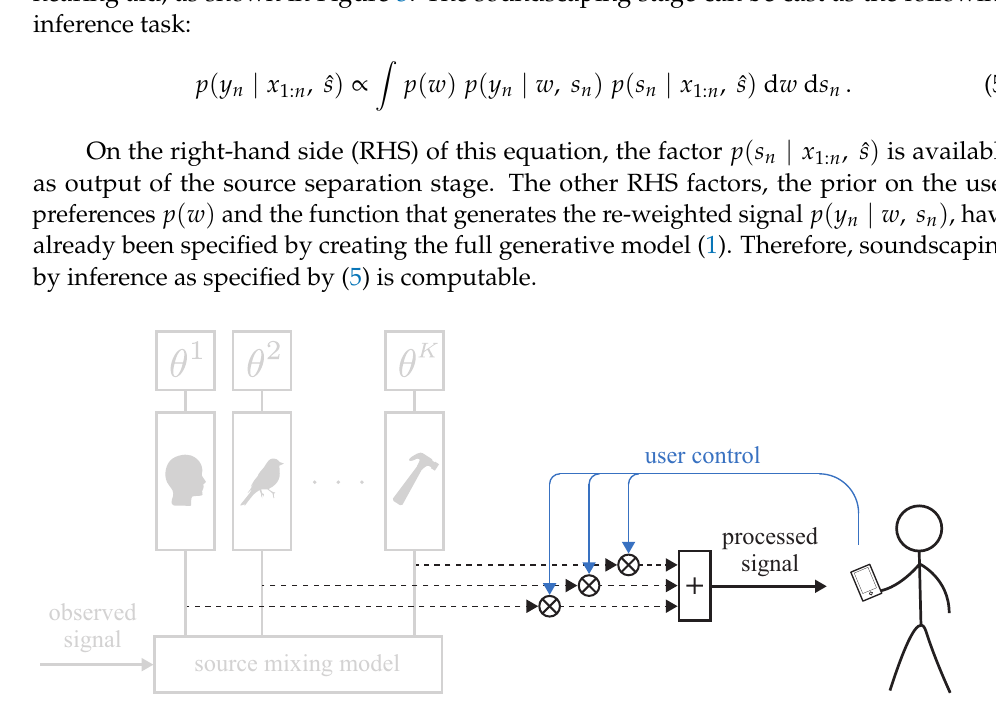
Figure 3. An overview of the soundscaping stage. The user controls the weights for the individual signals and performs source-specific amplification and